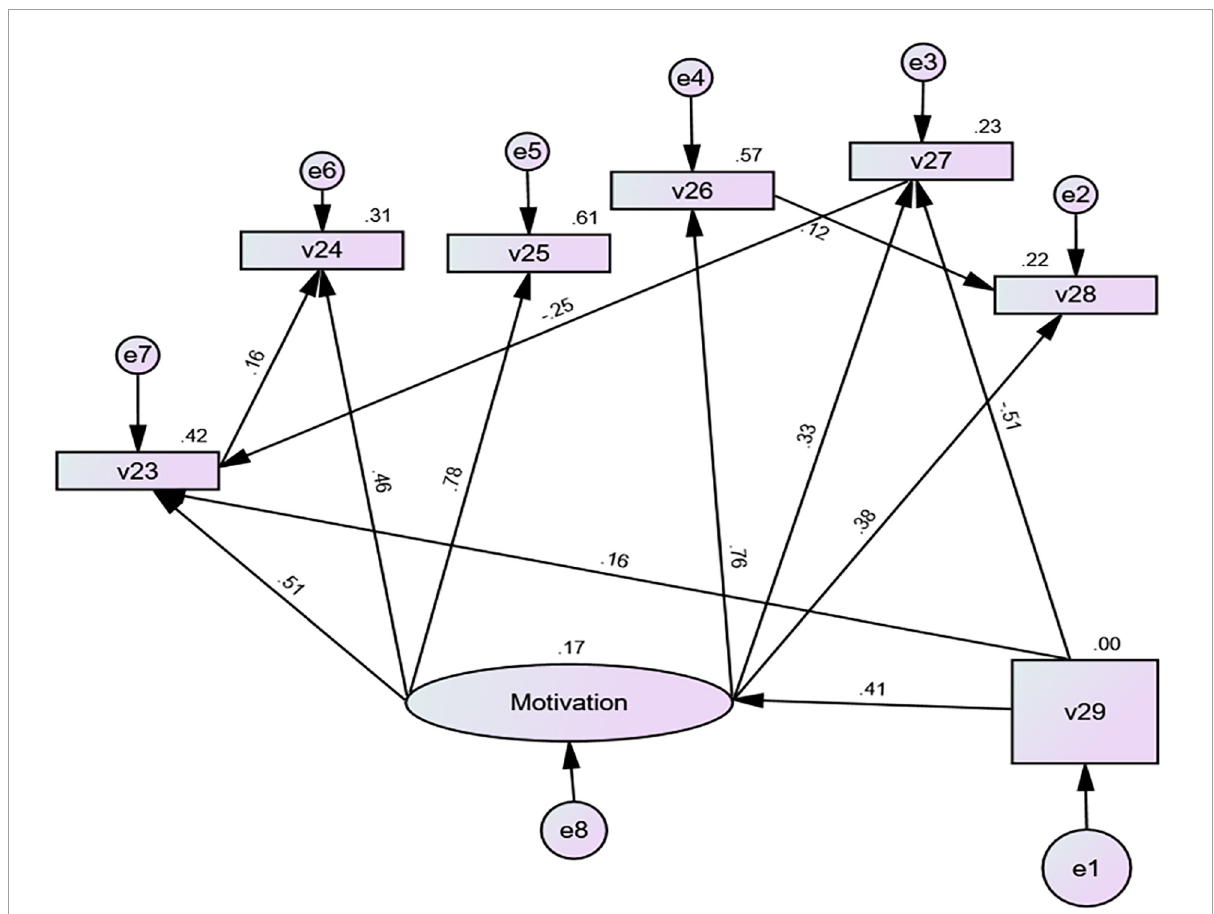
FIGURE2 The SEM model of relationships between the motivational intensity and learning motivation. V23, attitudes toward native speakers of English; V24, intrinsic interest; V25, English culture; V26, ultimate goal; V27, learning situation; V28, parental encouragement; V29, motivational